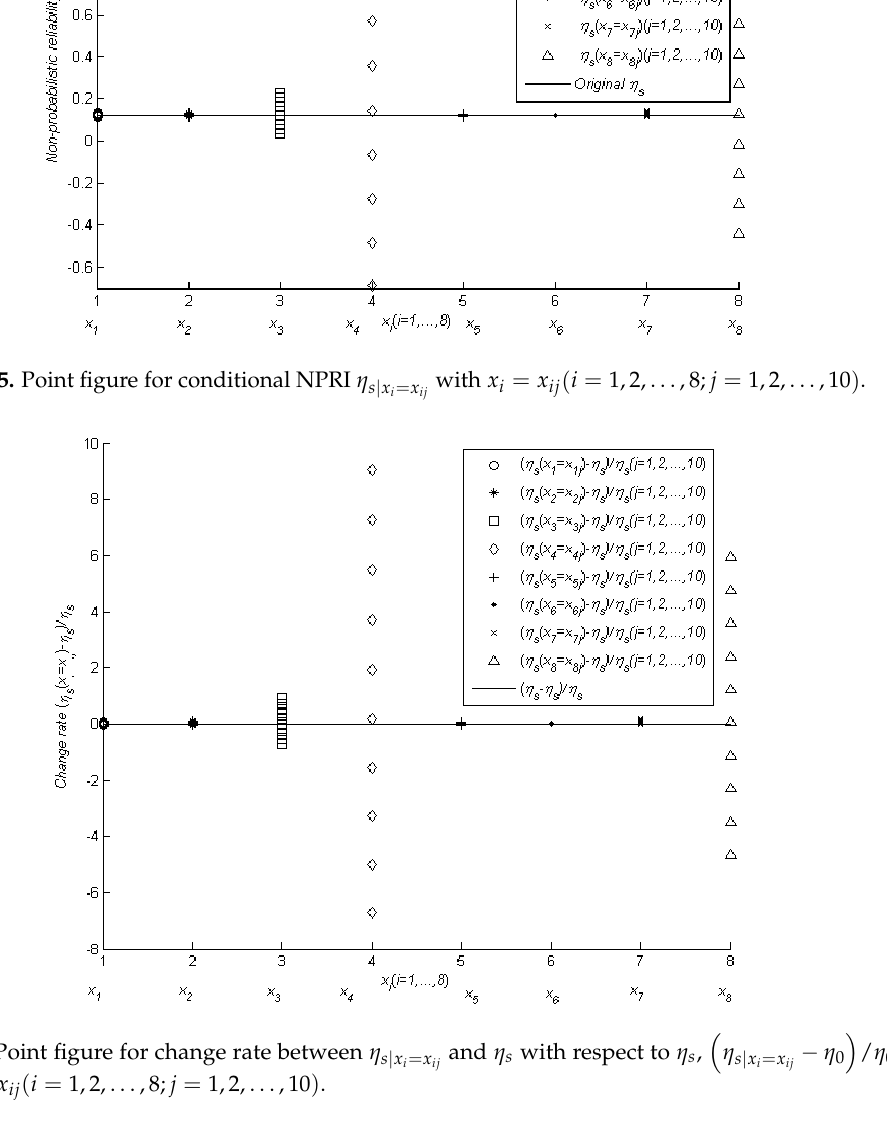
and η s with respect to η s , i = x ij